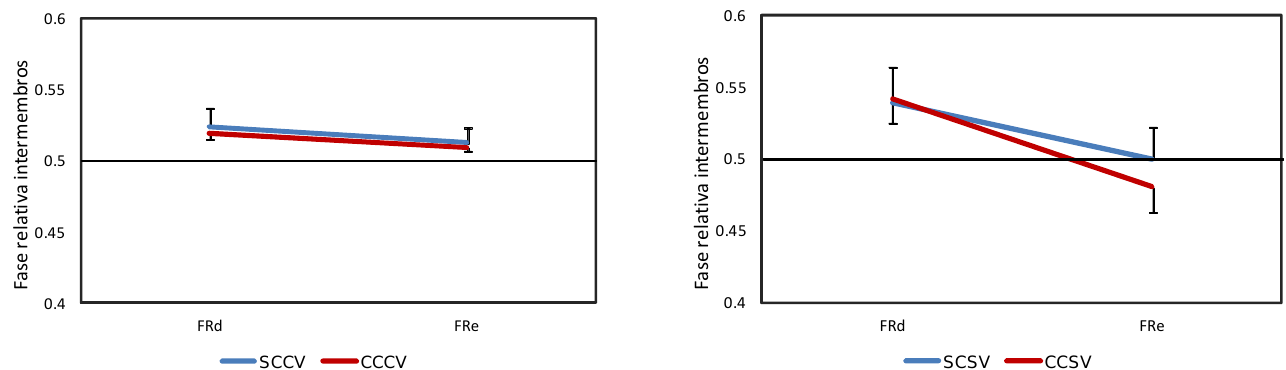
Figura 7. Média e desvio-padrão da fase relativa intermembros nas condições experimentais com e sem o cão, mas com uso da visão (lado esquerdo) e com e sem o cão, mas sem o uso da visão (lado direito).